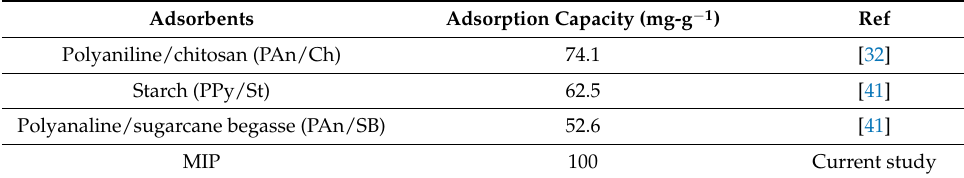
Table 8. Adsorptions capacity of acid black-234 dye on different adsorbents.